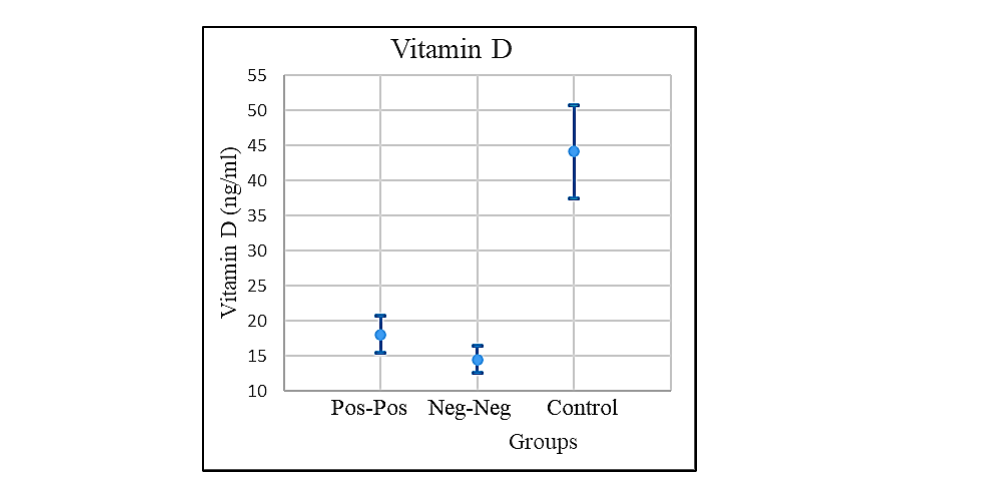
Figure 4. The vitamin D mean levels and the confidence intervals for COVID-positive, COVID-free patients, and the control groups.